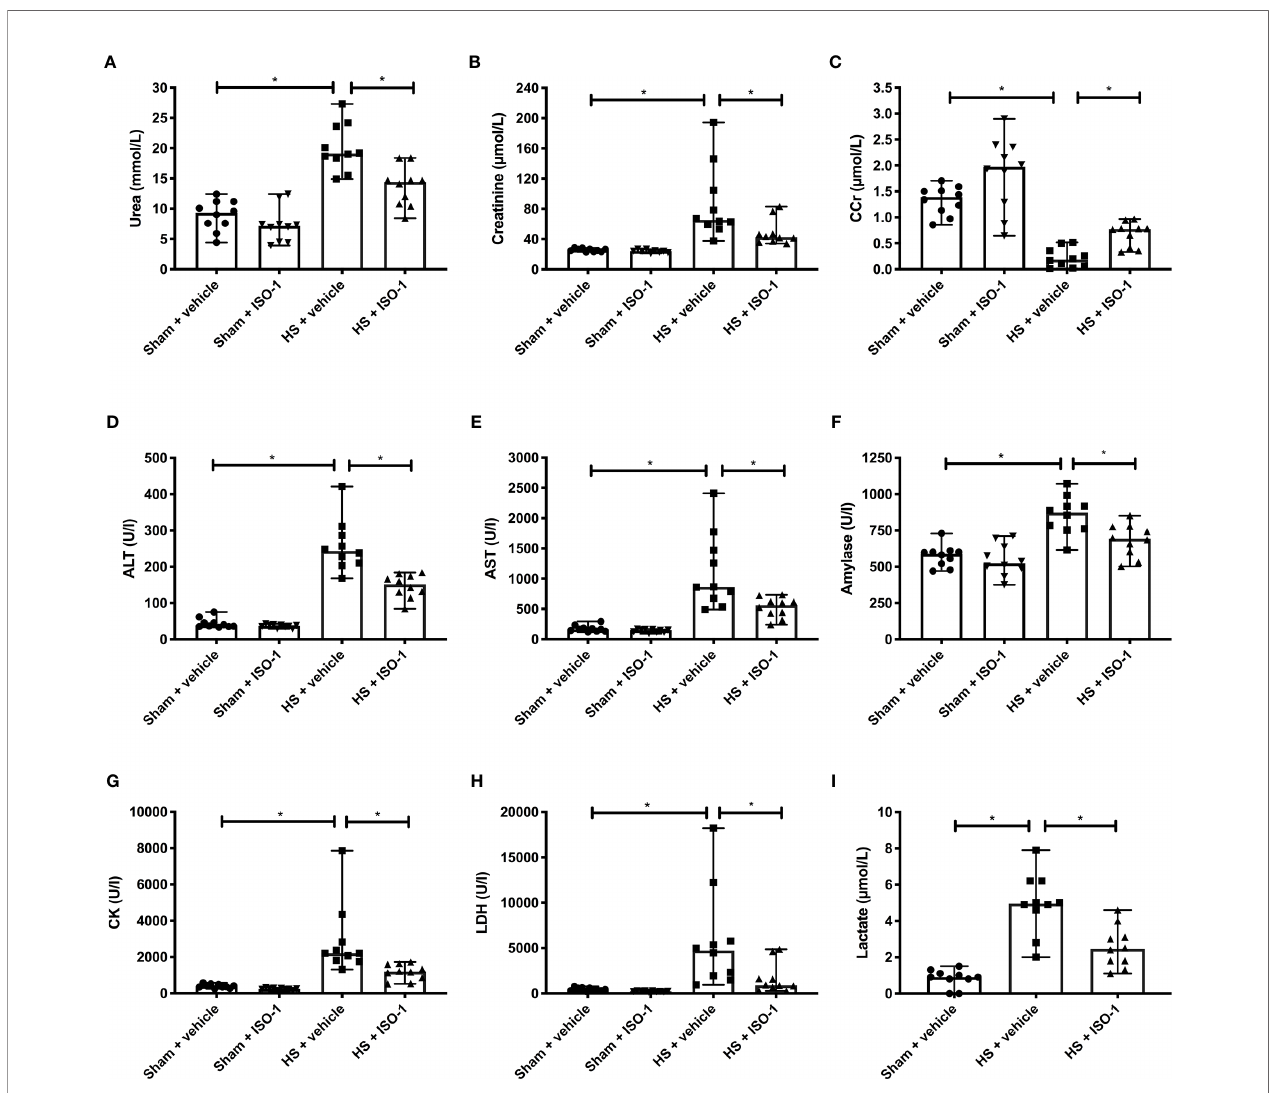
FIGURE 3 | Treatment with ISO-1 attenuates HS-induced organ damage in a short-term follow-up acute HS model. Rats weresubjected to haemorrhagic shock (HS) and 4 h after resuscitation, levels of serum (A) urea, (B) creatinine, (C) creatinine clearance (CCr), (D) alanine aminotransferase (ALT), (E) aspartate aminotransferase (AST), (F) amylase, (G) creatine kinase (CK), (H) lactate dehydrogenase (LDH) and (I) lactate were determined. Sham-operated rats were used as control. Data are expressed as median with range of ten animals per group. Statistical analysis was performed using one-way ANOVA followed by a Bonferroni ’ s post-hoc test. *p < 0.05 denoted statistical signi fi